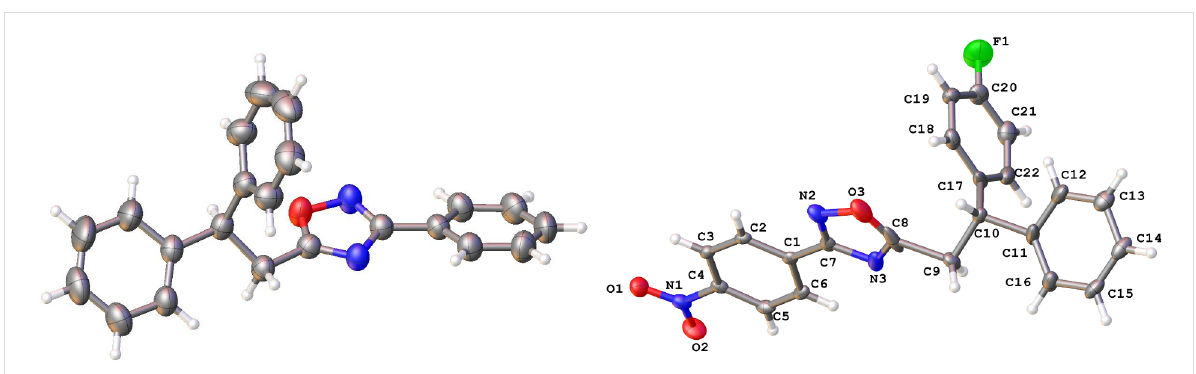
Figure 4: X-ray crystal structures of compounds 2a (left) (CCDC 1526767) and 2m (right) (CCDC 1526105); ellipsoid contours of probability levels are 50%.